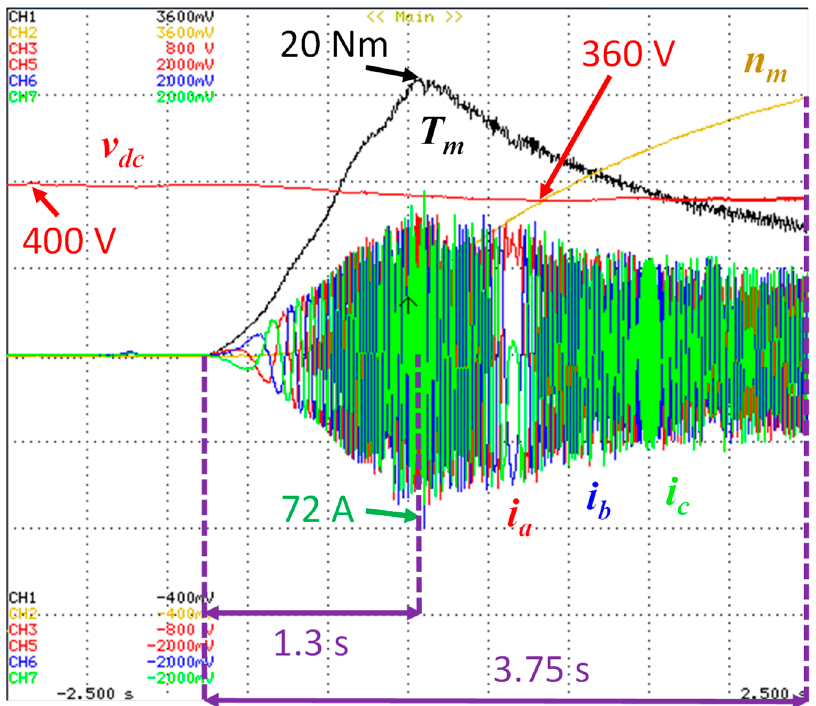
Figure 20. Experimental results of the traction system with an accelerator pedal as the input: the torque ( T m ) and speed ( n m ) of the SRPM machine; dc-link voltage ( v dc ); stator windings’ currents ( i a , i b , i c ).